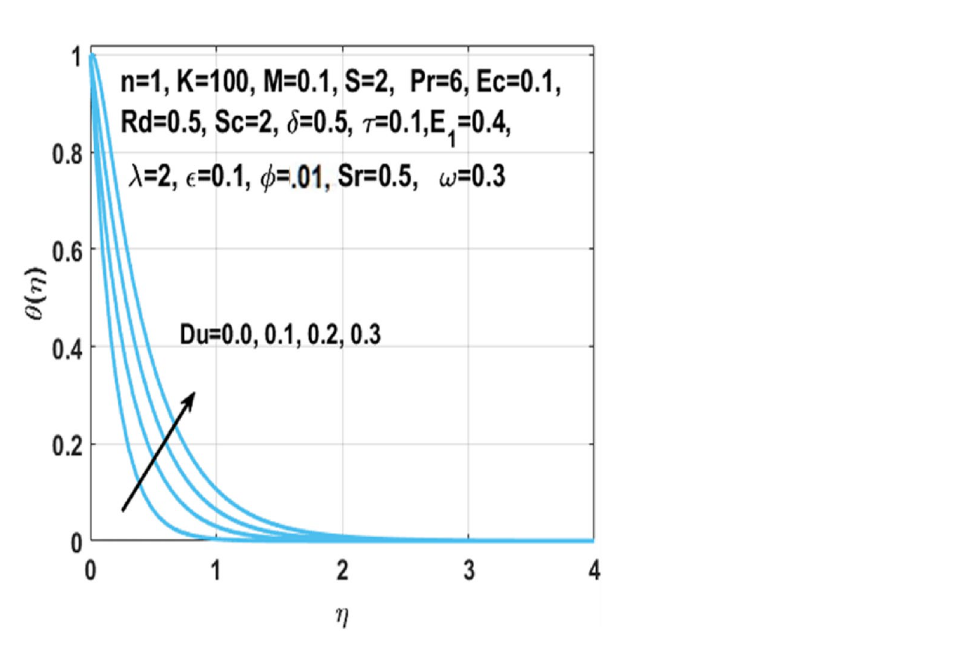
Figure 5. Impact of Du on θ(η)